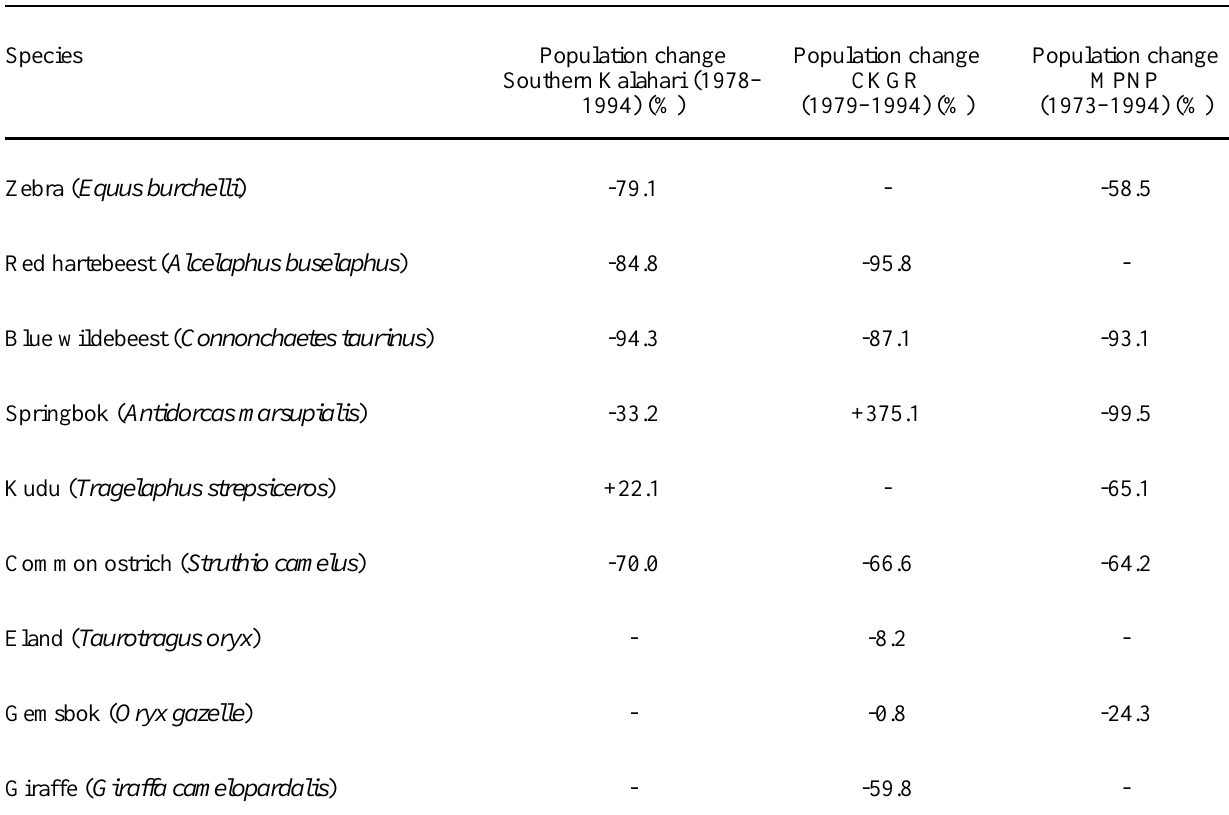
Table 2 . Population change of selected wild animal indicator species between the 1970s and 1994 for the southern Kalahari system associated with Khawa (data sources: DHV [1980] and DWNP [1994 a, b ]; modified from Boggs [2000]) and the northern Kalahari system associated with Kedia (data sources: Van Der Maas [1995] and Bonifica [1992]). CKGR = Central Kalahari Game Reserve; MPNP = Makgadikgadi Pans National Park. “-” refers to no data